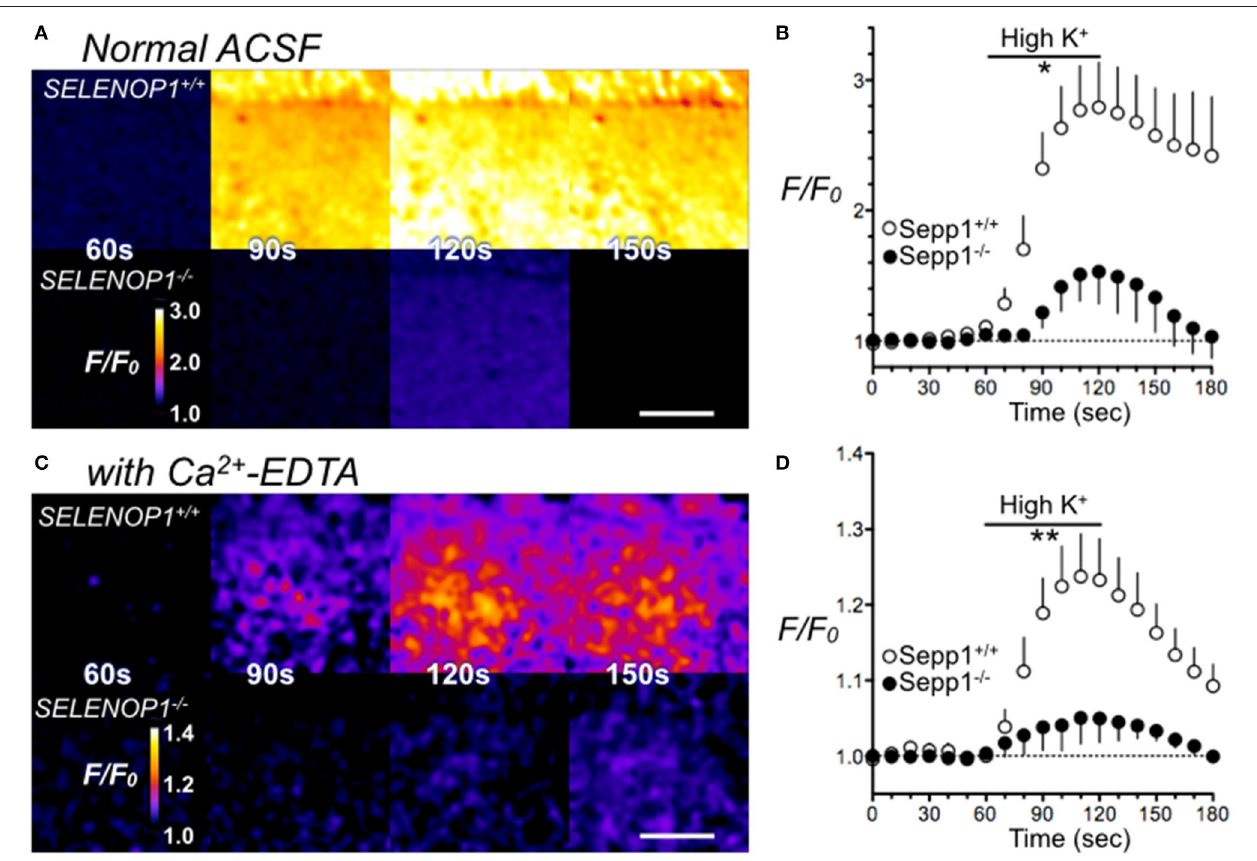
FIGURE 4 | Impaired Zn 2 + release in SELENOP1 KO hippocampus. (A) Zn 2 + release from hippocampal slices of SELENOP1 − / − and WT mice visualized